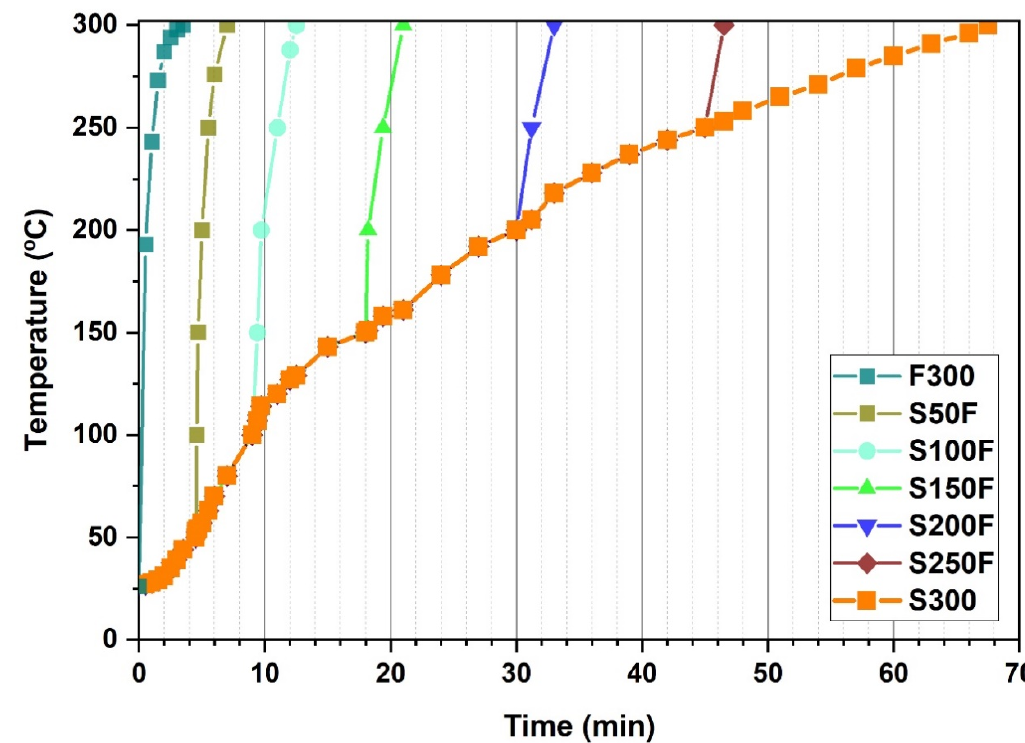
Figure 2. Temperature profile of the reaction medium during the combined slow-fast heating experiments to form LiFePO 4 microcrystalline particles.